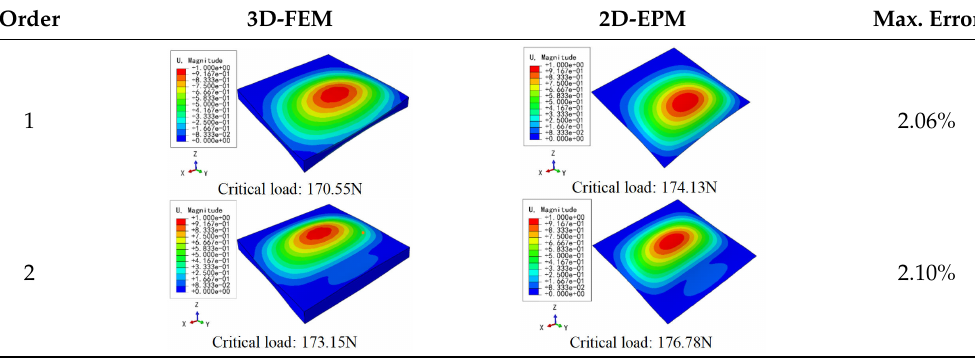
Table 8. Comparison of the buckling modes and critical loads (N) between 3D-FEM and 2D-EPM under the conditions in Case